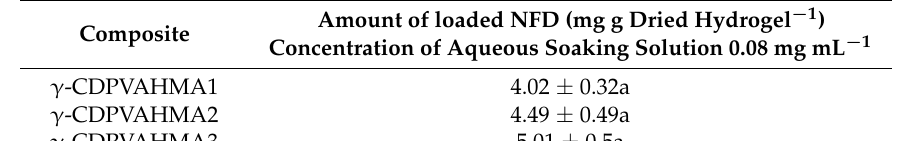
Table 4. Amount of NFD loaded into the γ -CDPVAHMA formulations. Results indicate the average ( n = 3) ± standard deviation values. The same letters beside the standard deviation denotes the absence of statistical differences using Tukey HSD, at 95% confidence level).